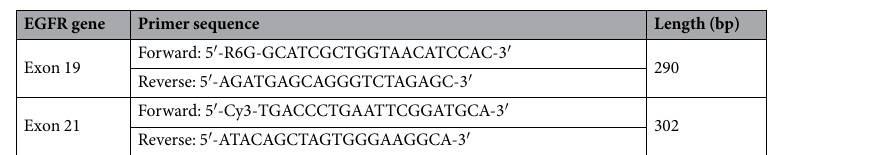
Table 2. Labeled primers used for the detection of mutations in